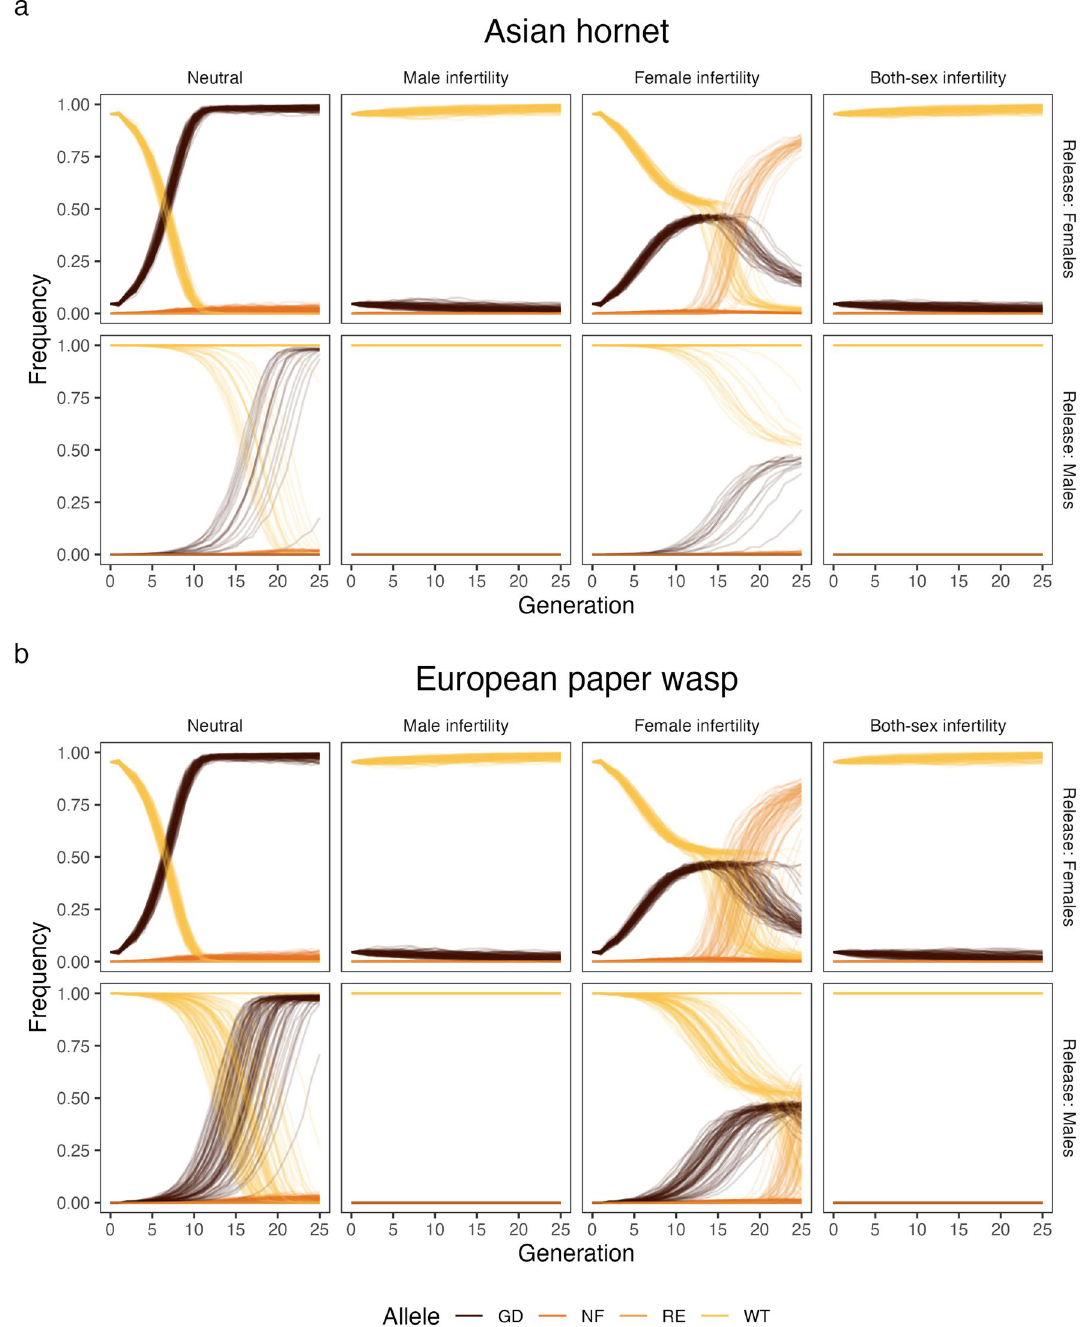
Figure 2. Frequencies of wildtype (WT), gene drive (GD), resistance (RE), and non-functional (NF) alleles in a female Asian hornet population ( a ) and a female European paper wasp population ( b ) by gene drive strategy and release gene drive carriers (females or males). The different strategies (neutral, male infertility, female infertility, and both-sex infertility) determine how the gene drive operates. In the neutral strategy there is no fitness cost to having the gene drive, whereas in the infertility strategies, the designated sex cannot reproduce when homo- or hemizygous for the gene